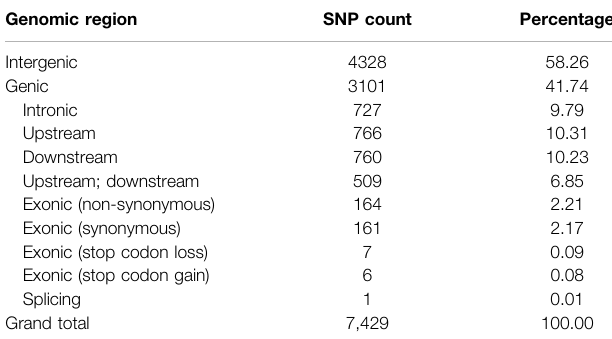
TABLE1| Countsofsigni fi cantlyassociatedSNPfor215 G . arboreum genotypes across three geographical locations. Genomic